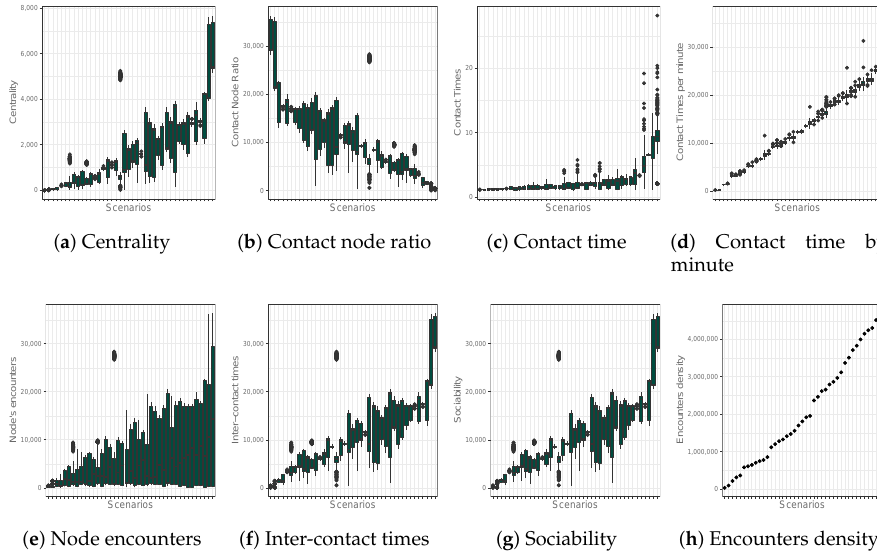
Figure 5. Scenario characteristics range distribution.